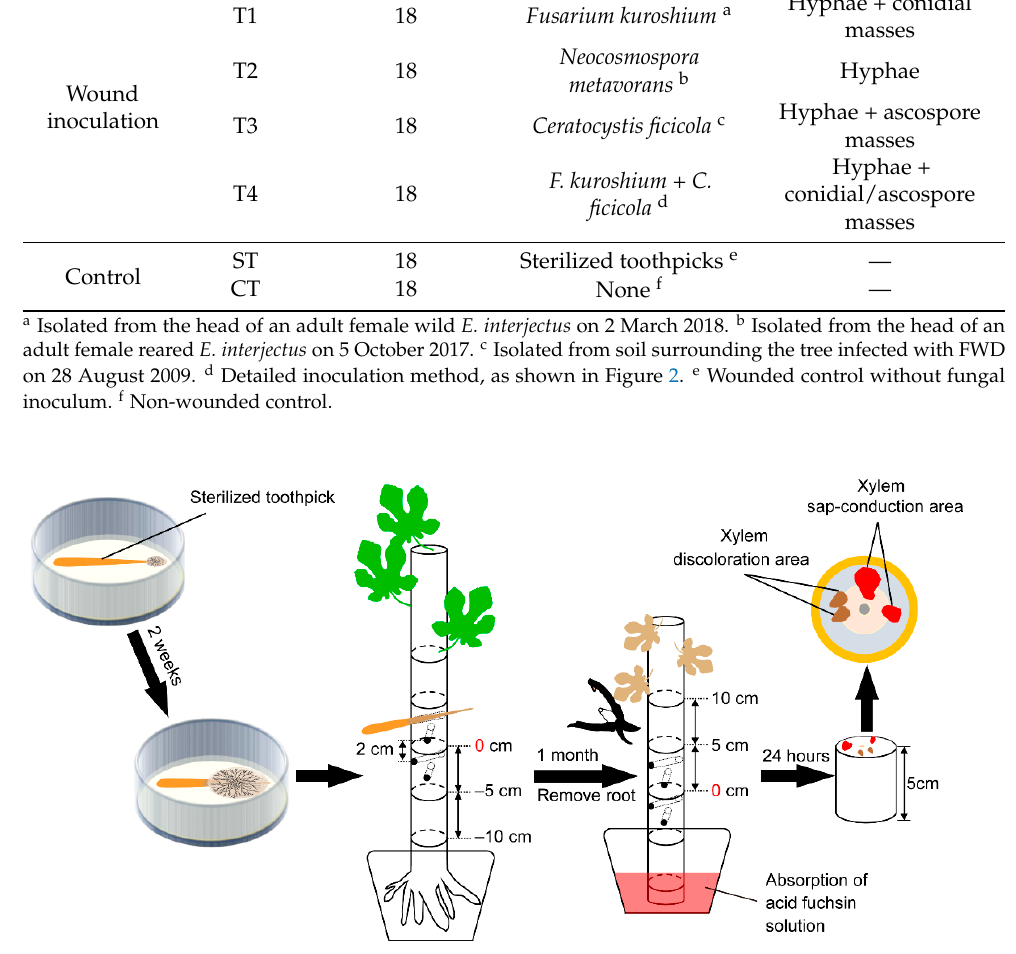
Figure 1. The layout of the inoculation site of the fungi tested on the fig sapling and observation of the cut end of the sapling after dye injection.